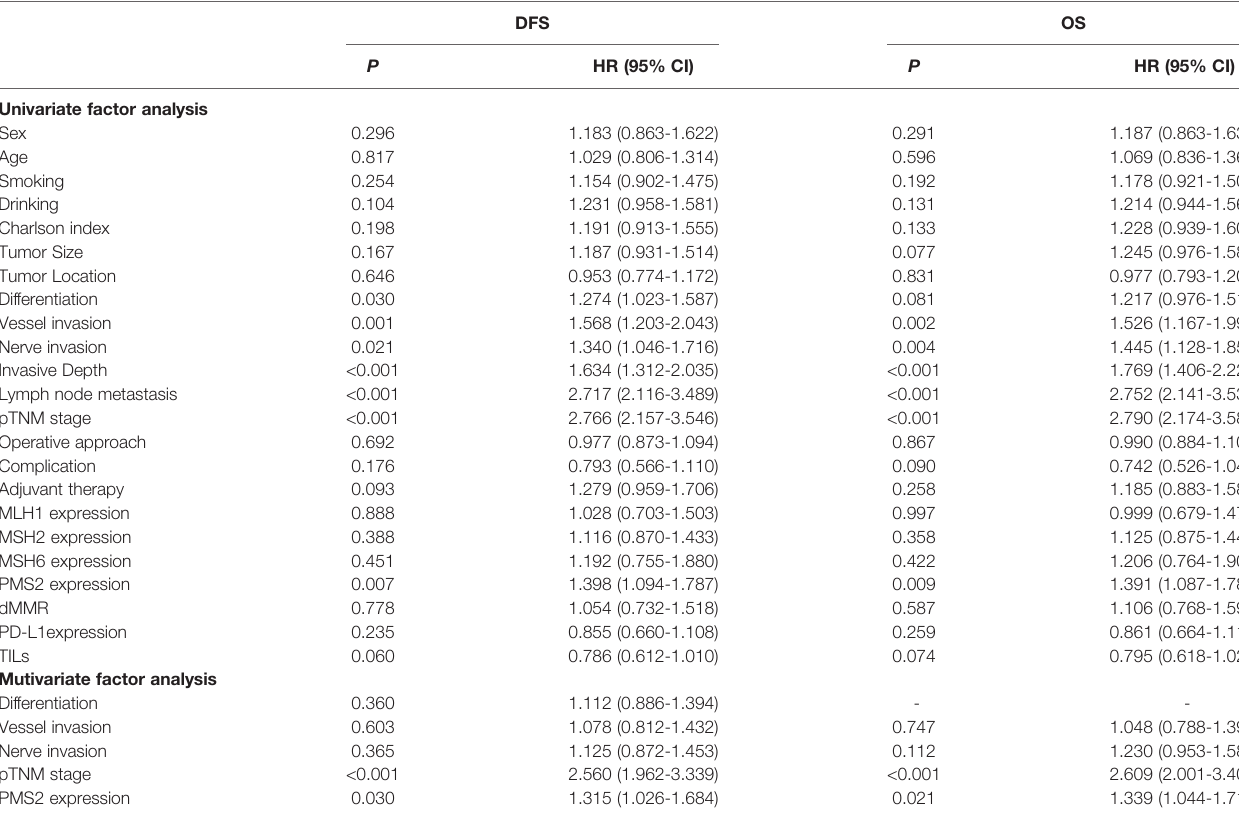
TABLE 4 | Univariate and multivariate analyses of prognostic factors for